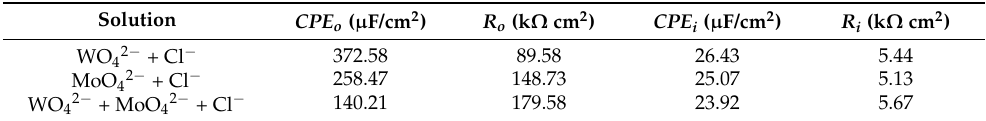
Table 4. Fitted values of CPE o , R o , CPE i and R i for Q235 carbon steel in WO 4 2− + Cl − , MoO 4 2− + Cl − and WO 4 2− + MoO 4 2− + Cl − solutions.